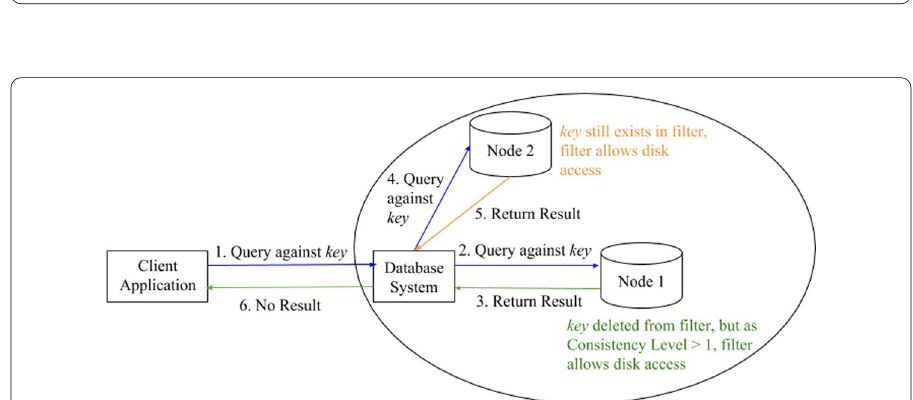
Fig. 4 Modifying the behavior of Cuckoo Filter makes sure the Database System infers correct result with our proposed scheme applied, in the case where Consistency Level requirement >